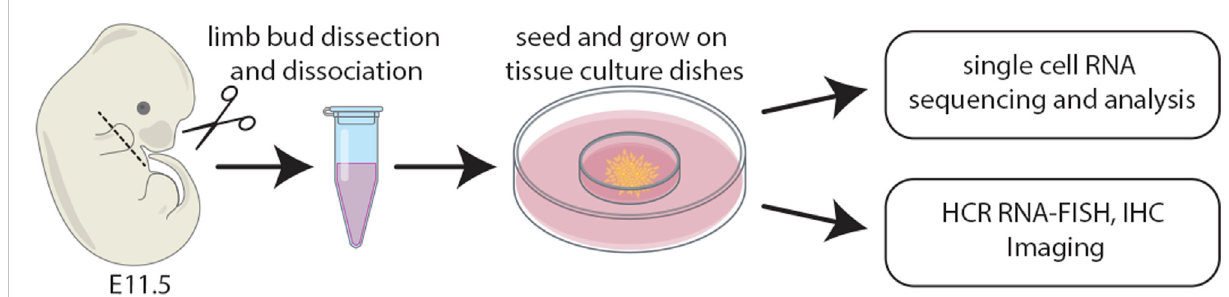
FIGURE 1 Schematic of the experimental design whereby distal limb mesenchyme was dissected, dissociated, and single cells captured. The distal most third of forelimb buds were micro-dissected and pooled from E11.5 mouse embryos. Cell suspensions were inoculated onto 60 mm tissue culture dishes and subsequently processed for either single cell RNA sequencing, HCR RNA-FISH, or